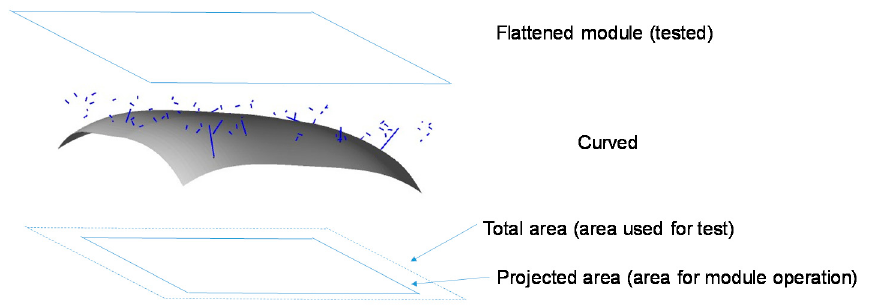
Figure 5. Illustration of the multiple definitions of the module area.